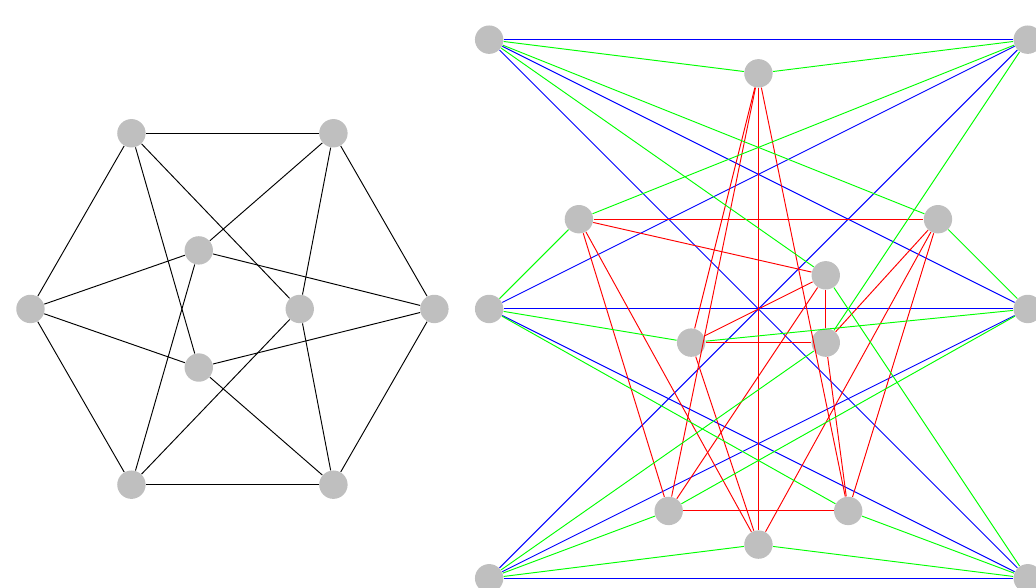
. On the 2 Z theories to produce 2 × 2